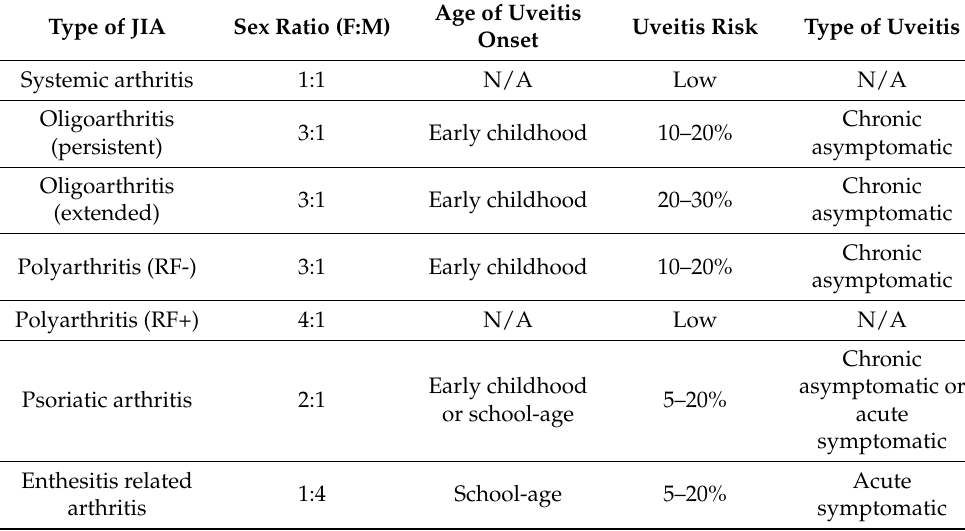
Table 1. Juvenile idiopathic arthritis (JIA) and relative risk of uveitis. Type of JIA